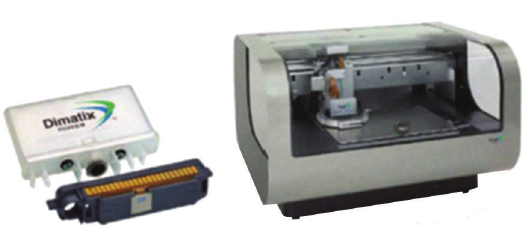
Figure 2: Two conductor segments for mutual inductance calcula- tion.